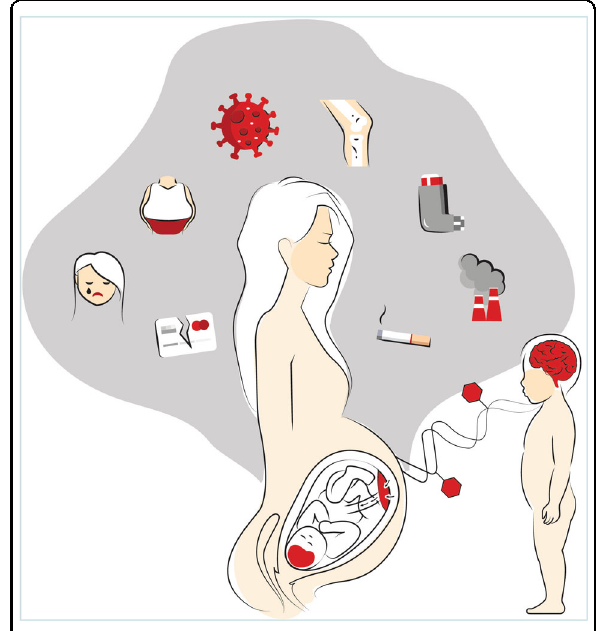
Fig. 1 Maternal immune activation, triggered by acute and systemic chronic in fl ammation, is proposed to affect fetal neurodevelopment, through in fl ammatory and epigenetic mechanisms. Common maternal disease and environmental factors including obesity, gestational diabetes, pre-eclampsia, smoking, pollution, low socioeconomic status, depression, psychosocial stress, autoimmune diseases and asthma are implicated in systemic chronic in fl ammation. In addition, infection is involved in acute in fl ammation. These maternal in fl ammatory states play a key role in immune activation during pregnancy through the placenta and immature blood-brain barrier to cause dysfunction in the developing fetal brain and prime the child to be susceptible to future hits through microglia activation and epigenetic alterations, manifesting a spectrum of diverse neurodevelopmental outcomes with varied expression and